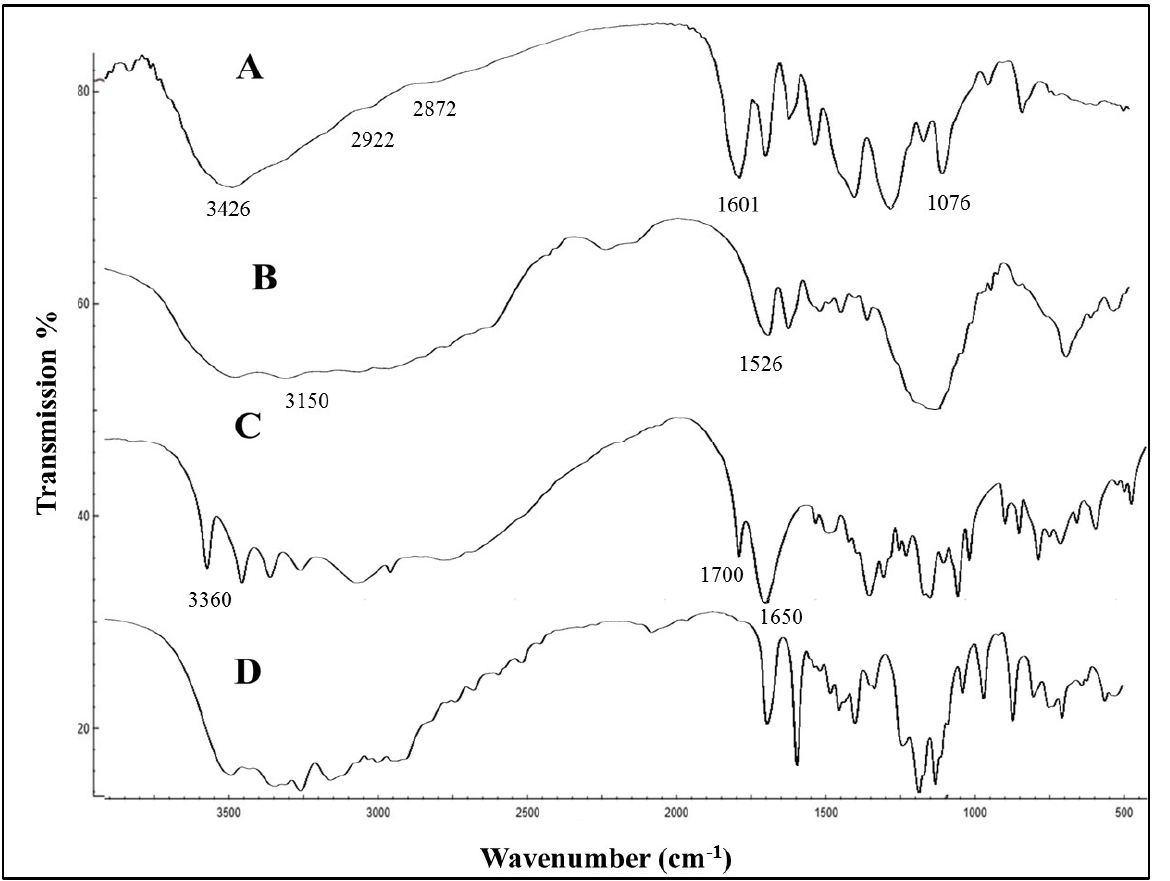
Figure 4. FTIR spectra of CS ( A ) showed 3426 cm − 1 (–OH and –NH 2 ), 2922 cm − 1 , 2872 cm − 1 (–CH),